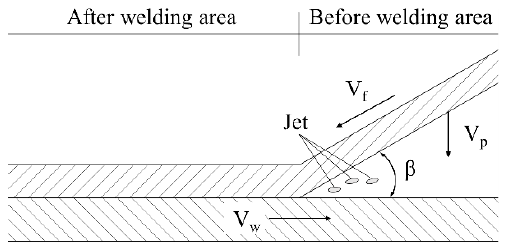
Figure 5. Schematic diagram of the impact welding process. Table 1. Influence of Weldment Combination Parameters.